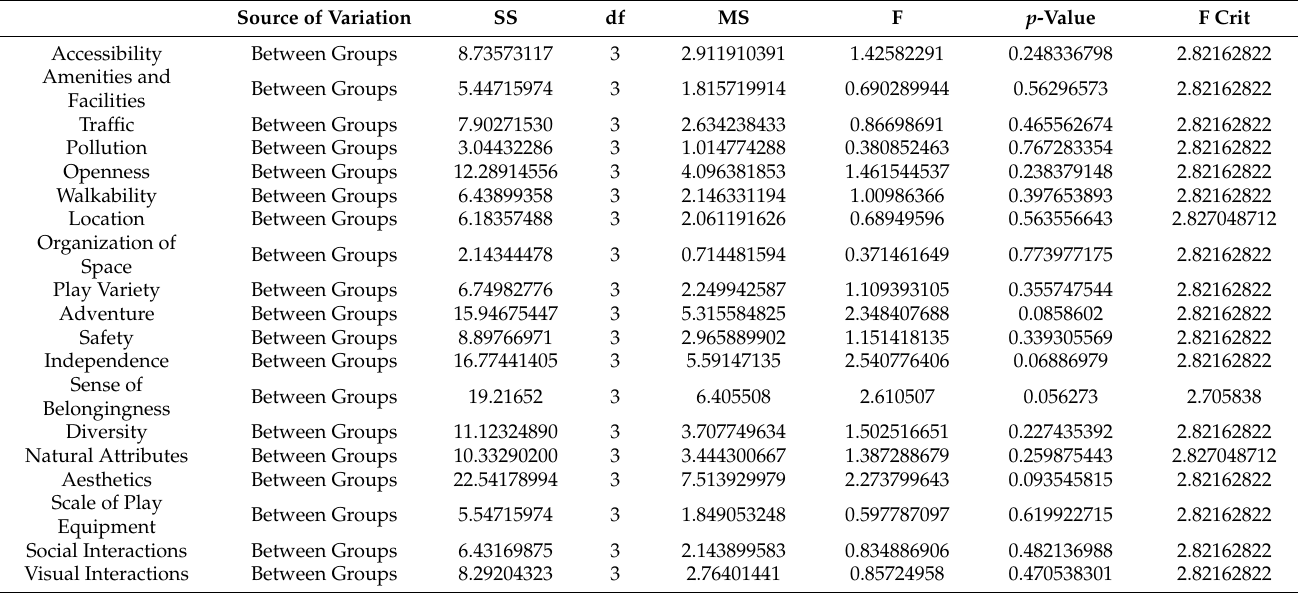
Table A2. F value and the Fcrit value for each of the